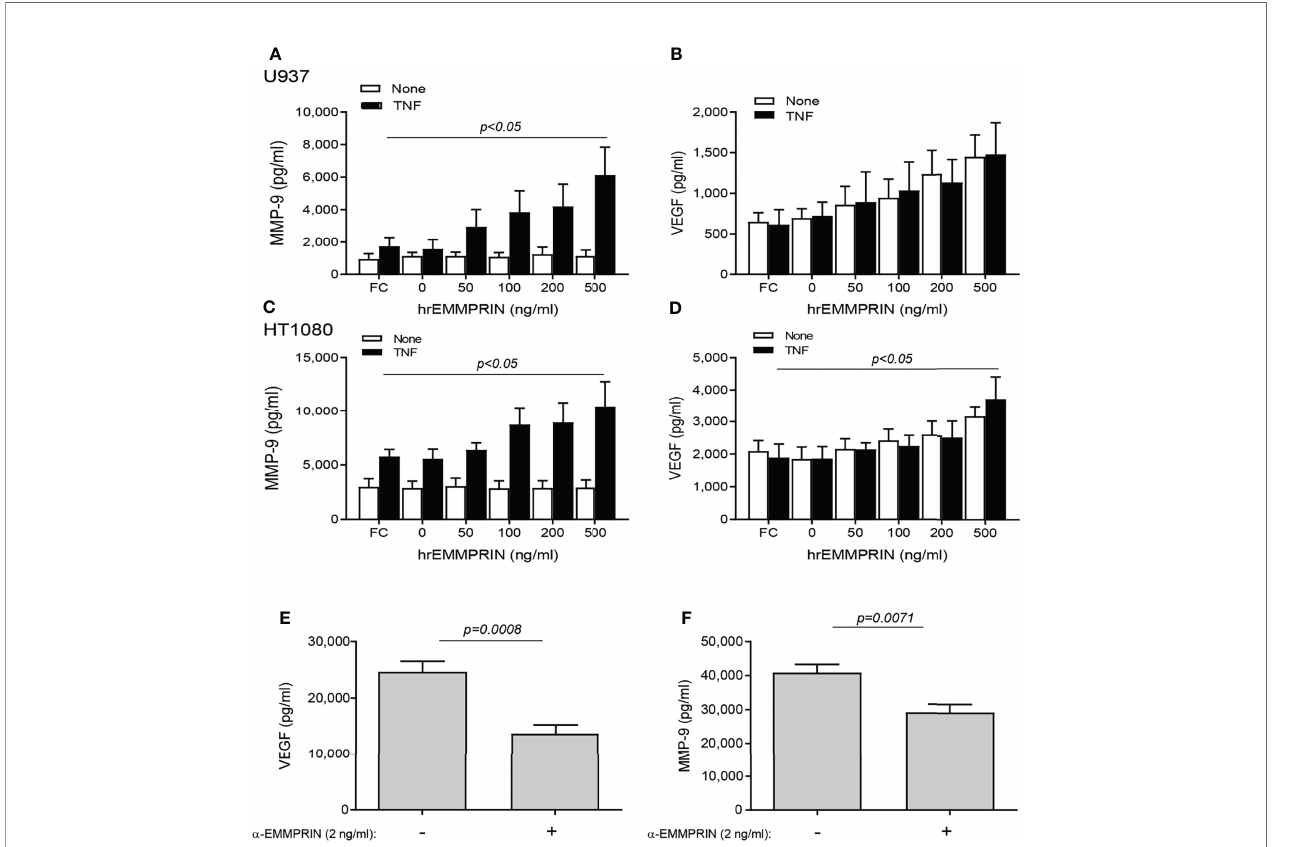
FIGURE 5 | EMMPRIN regulates the increase in VEGF and MMP-9. Cells were seeded in single cultures (2x10 4 cells/well in 200 m L for HT1080 or U937), with or without TNF a (1ng/mL), and increasing concentrations of recombinant human EMMPRIN or the IgG Fc fragment (Fc, at 200 ng/ml) were added as indicated. After 48h of incubation, supernatants were collected and concentrations of (A, C) MMP-9 and (B, D) VEGF were determined by ELISA (n=5-6 in all groups). The one-way ANOVA test, followed by the Dunn ’ s multiple post-hoc comparison test were used. The involvement of EMMPRIN was demonstrated by adding the blocking anti-EMMPRIN antibody (2 ng/ml) to a co-culture of HT1080 and U937 cells (2x10 4 cell/well each) in the presence of TNF a (1 ng/mL). After 48h, the concentration of (E) VEGF and (F) MMP-9 were estimated by ELISA. The unpaired t test was used (n=7 in each